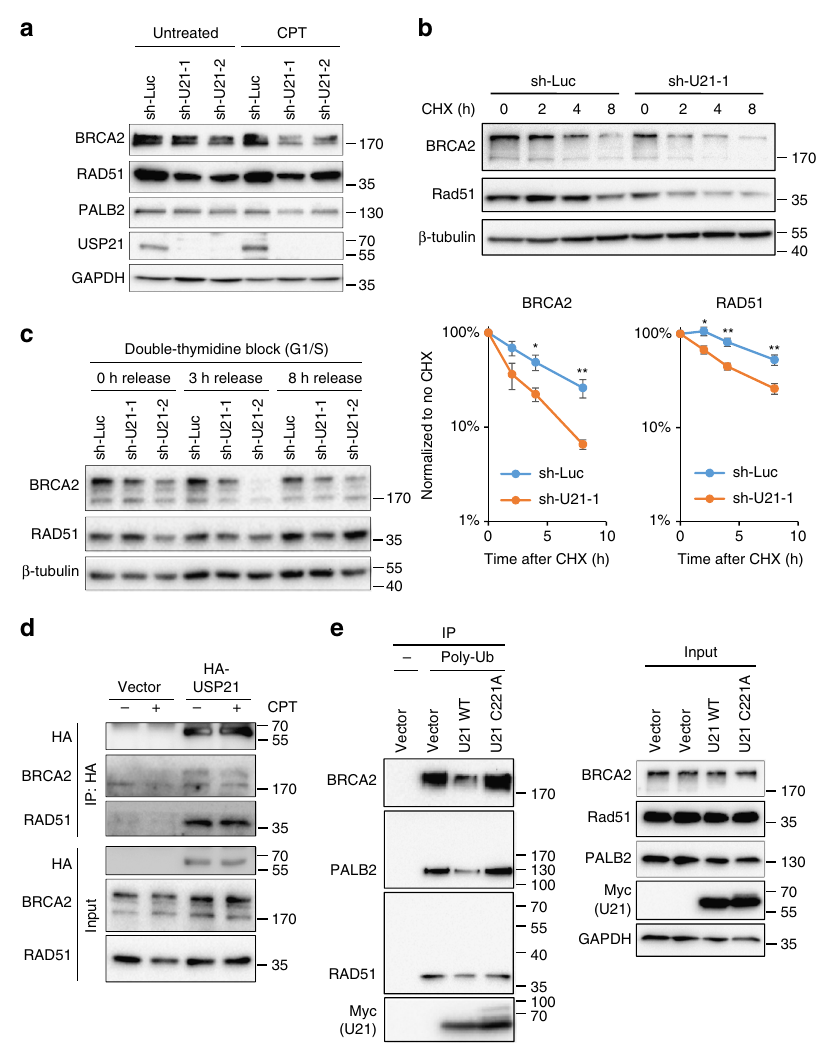
Fig. 2 USP21 controls BRCA2 protein levels and ubiquitination. a Western blot analysis of the indicated proteins in the presence or absence of USP21 knockdown. Asynchronous U2OS cells were either left untreated or treated with CPT for 1 h. One of three representative experiments is shown. b BRCA2 and RAD51 protein turnover in HEK293T cells in the presence of USP21 knockdown or sh-Luc control. Western blot analysis was performed at the indicated timepoints after cycloheximide (CHX) treatment. A quanti fi cation of BRCA2 and RAD51 protein levels normalized to β -tubulin and 0 h CHX is shown. Values are expressed as mean and s.e.m. from three (2 h) or six independent experiments (4 and 8 h timepoints), p -values are based on Student ’ s two-tailed t -test: * p < 0.05, ** p < 0.01. c Western blot analysis of BRCA2 and RAD51 levels in S phase cells. Following double-thymidine-block, cells were released for the indicated time frames prior to analysis. d IP using anti-HA conjugated beads in HEK293T cells transiently expressing empty vector or HA- USP21 in the presence or absence of CPT. Representative immunoblots from one of three independent experiments are shown. e Poly-ubiquitination analyses of the indicated proteins in cells expressing empty vector, Myc-USP21 WT (U21 WT) or Myc-USP21 C221A (U21 C221A). Endogenous poly-ubiquitin-chains were immunoprecipitated in the presence of MG-132 using TUBE1. Representative immunoblots from one of two